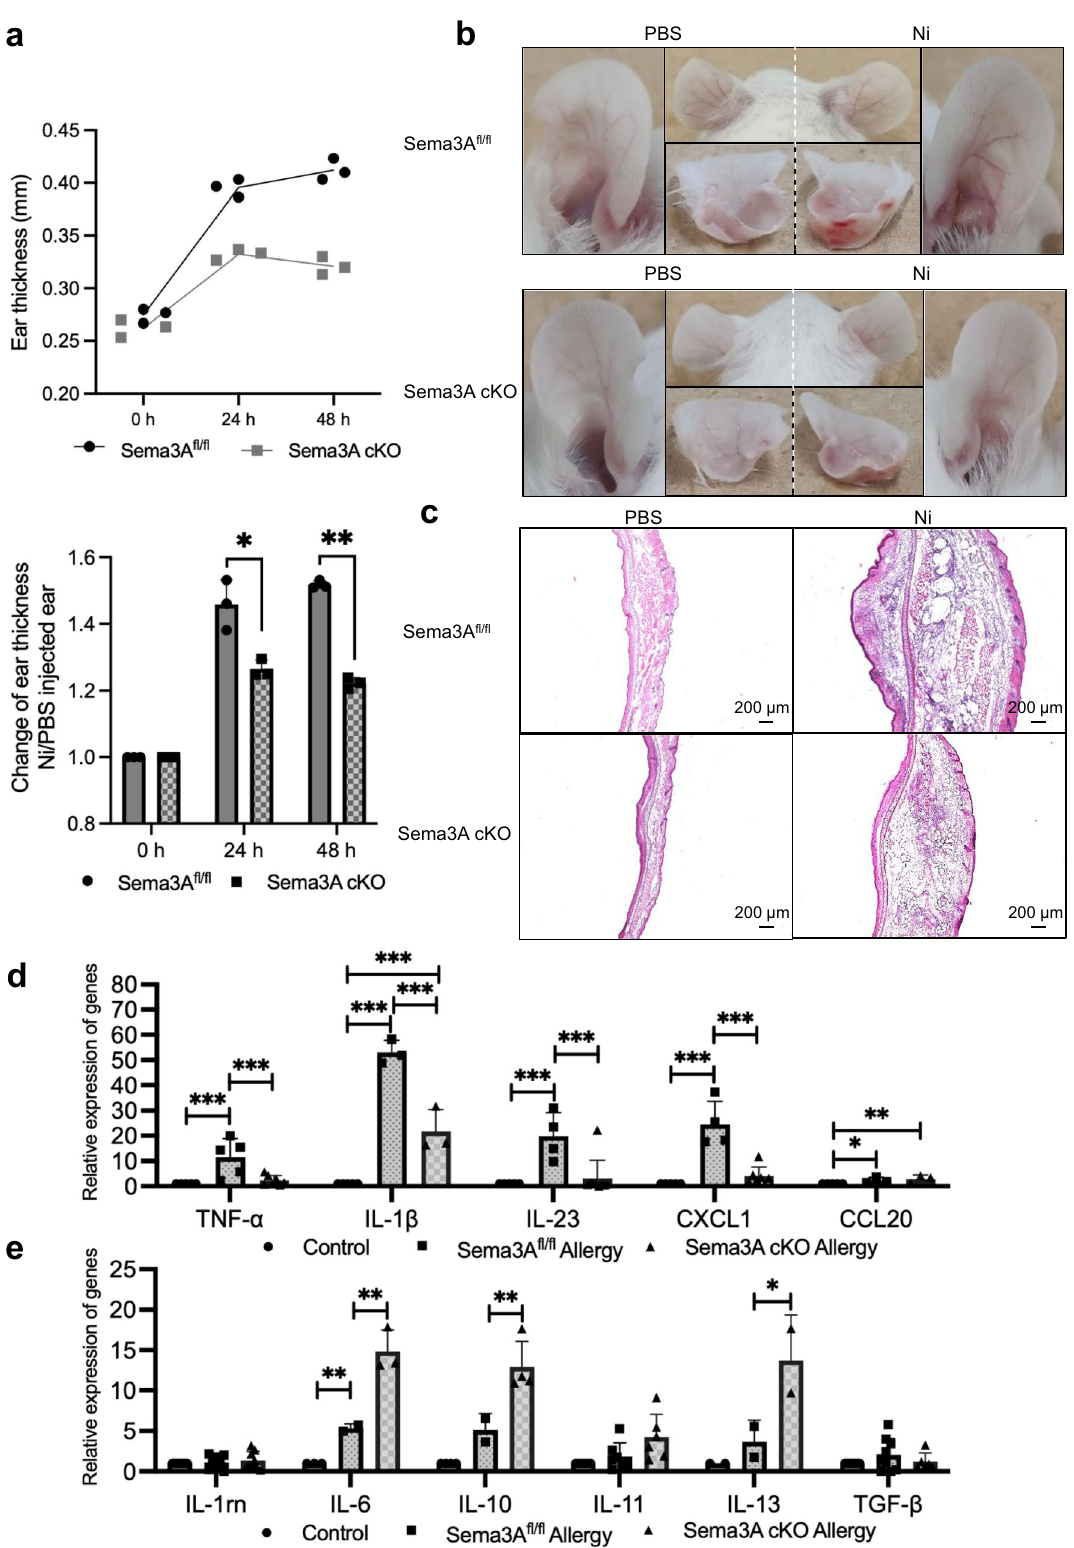
pathways 39 . In our study, both TNF- α and p38 kinase expression levels were inhibited when Sema3A was suppressed in keratino- cytes. In previous studies, signi fi cantly decreased TNF- α expres- sion in microglial cells in response to TLR4 stimulation was observed with the knockdown of the receptor of PlexinA1, which is a receptor of Sema3A 40,41 . These results re fl ect the